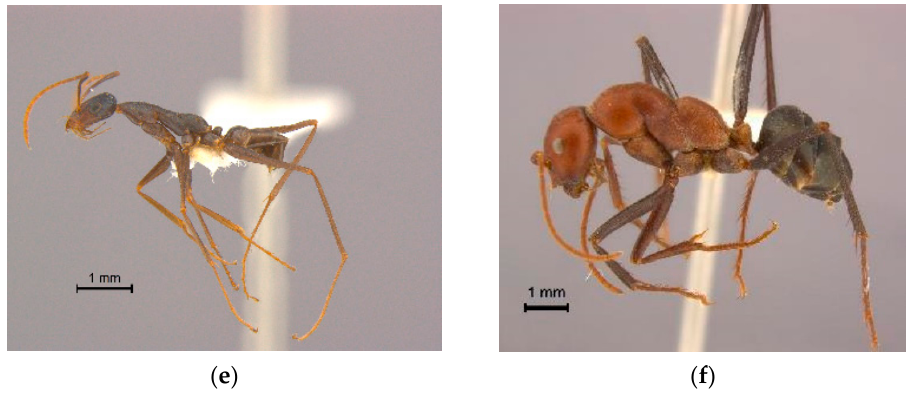
Figure 1. Representatives of the M. aeneovirens radiation. ( a ) M. iridescens ; ( b ) M. bagoti ; ( c ) member of the M. froggatti group; ( d ) member of Group A; ( e ) member of Group O; ( f ) member of the M. aeneovirens group. All specimens are minor workers.